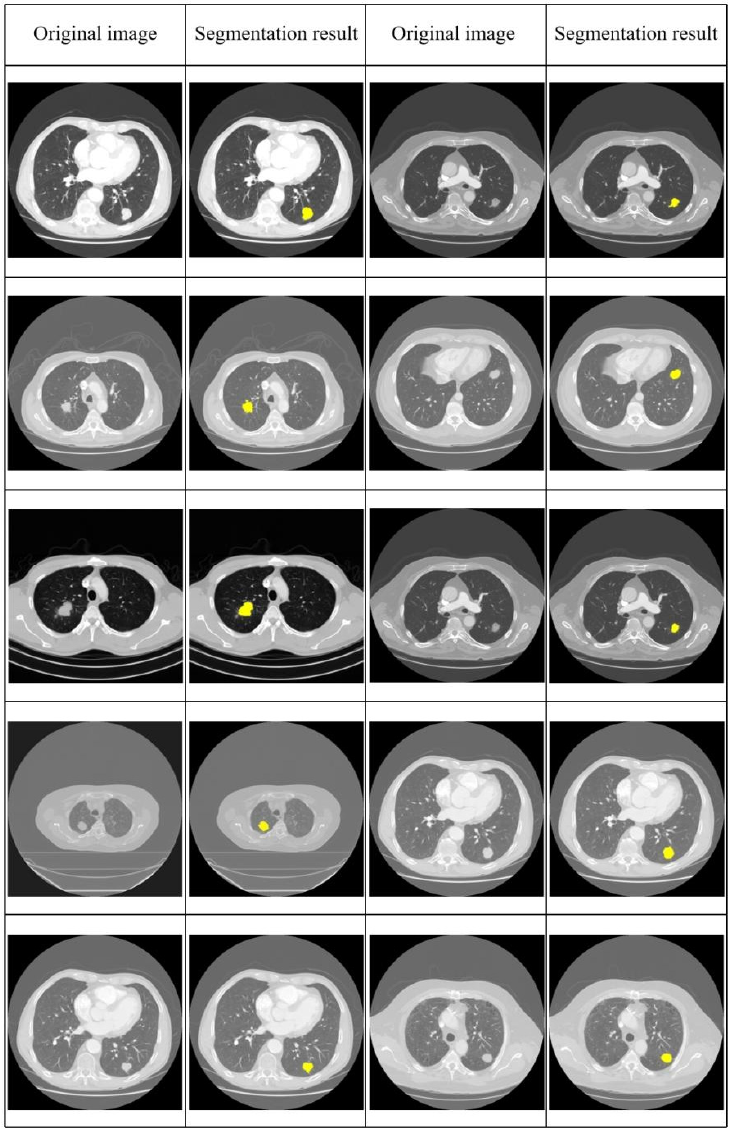
Figure 7. All used image segmentation results obtained with our proposed method, the yellow area represents the segmentation results.